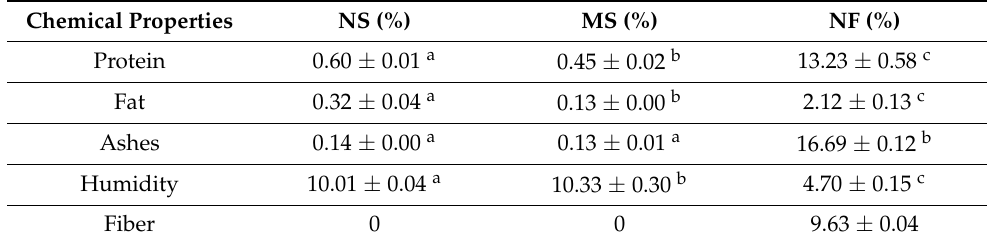
Table 1. Results of proximal analysis for native starch, modified starch and nopal